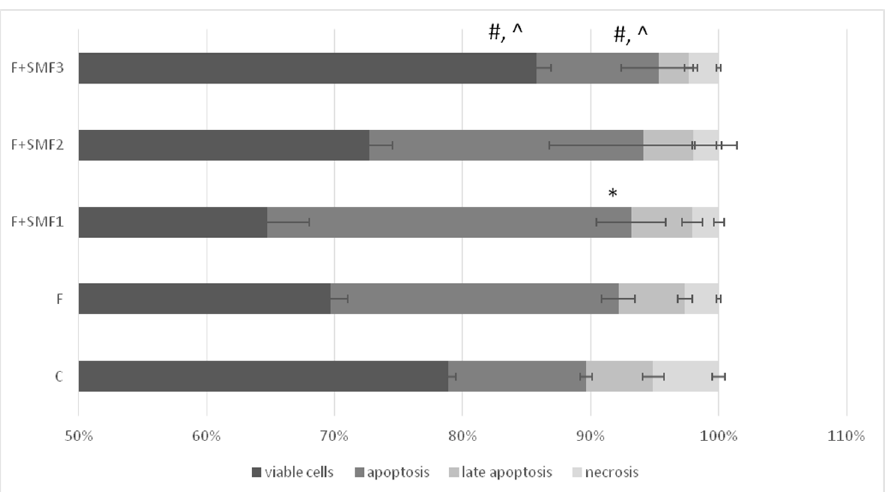
Figure 1. Apoptosis in fibroblasts co-exposed to fluoride and a SMF at a different magnetic induction for 12 h (C—control cells; F—NaF-treated cells; F + SMF1—NaF-treated cells exposed to SMF at a 0.45 T flux density; F + SMF2—NaF-treated cells exposed to SMF at a 0.55 T flux density; F + SMF3—NaF-treated cells exposed to SMF at a 0.65 T flux density). The results are expressed as the means ± SD, statistical significance: * p < 0.05 vs. C; # p < 0.05 vs. F; ^ p < 0.05 vs. F + SMF1).